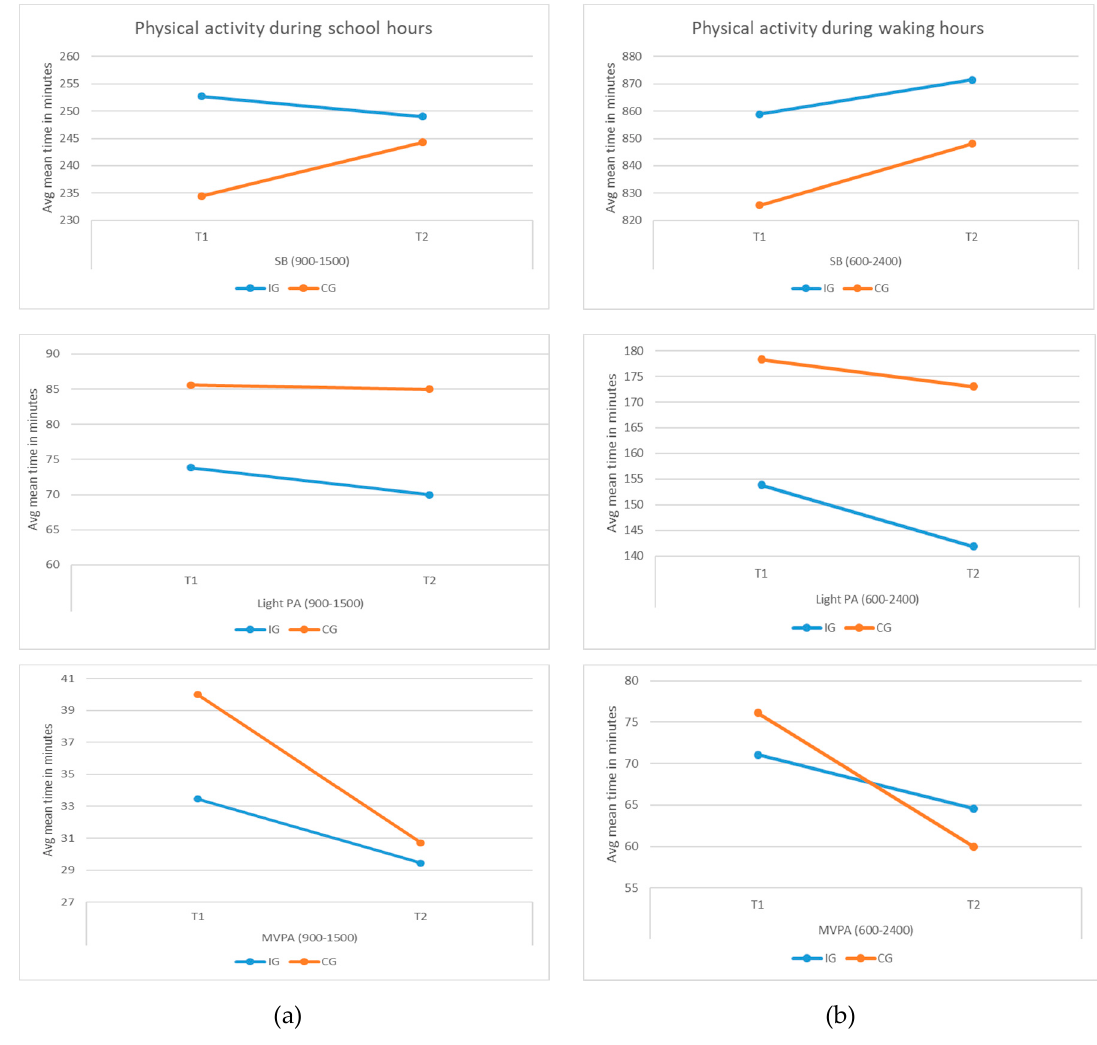
Figure 5. (a) Physical activity (in minutes) during school hours (09:00 − 15:00). (b) Physical activity (in Figure 5. ( a ) Physical activity (in minutes) during school hours (09:00 − 15:00). ( b ) Physical activity (in minutes) during waking hours (06:00 − 24:00). minutes) during waking hours (06:00 −